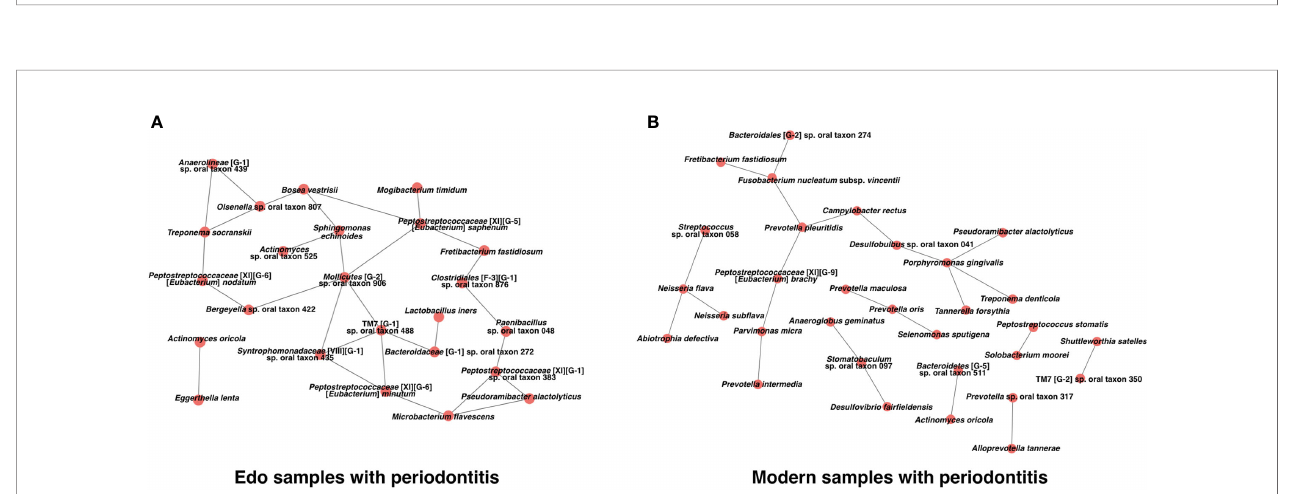
FIGURE 8 | Co-occurrence networks based on species in (A) Edo sample with periodontitis and (B) modern sample with